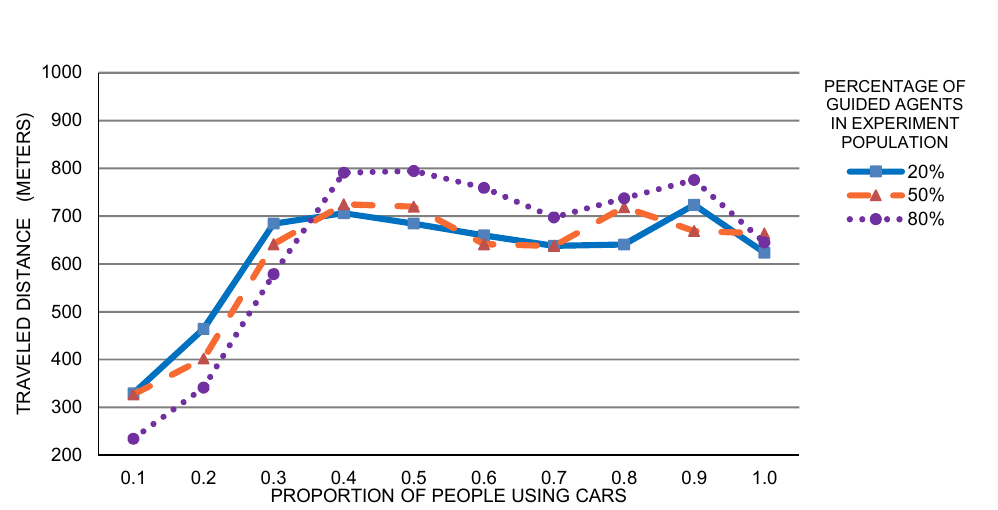
Figure 5. Variation of the mean traveled distance, as expressed by the difference between the mean distance of ‘Explorer’ and ‘Guided’